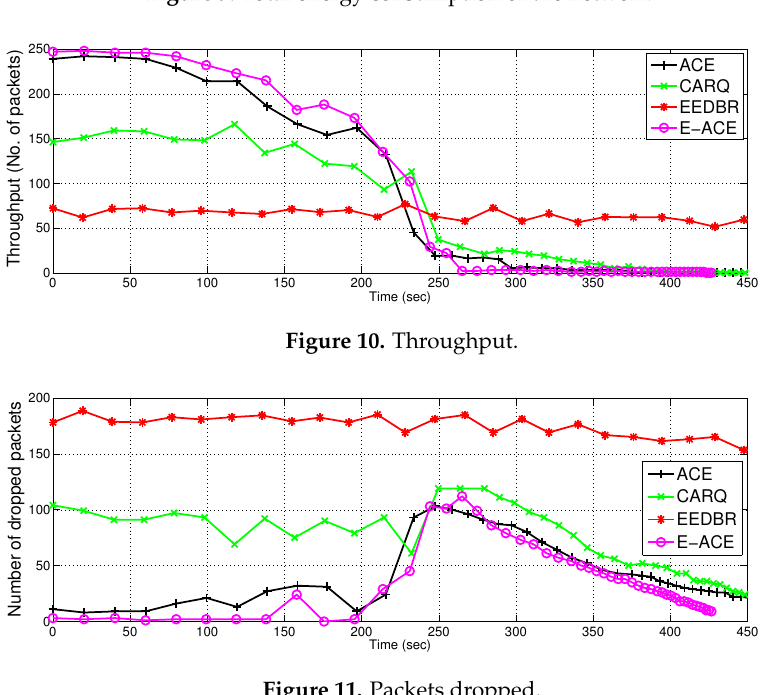
Figure 9. Total energy consumption of the network.